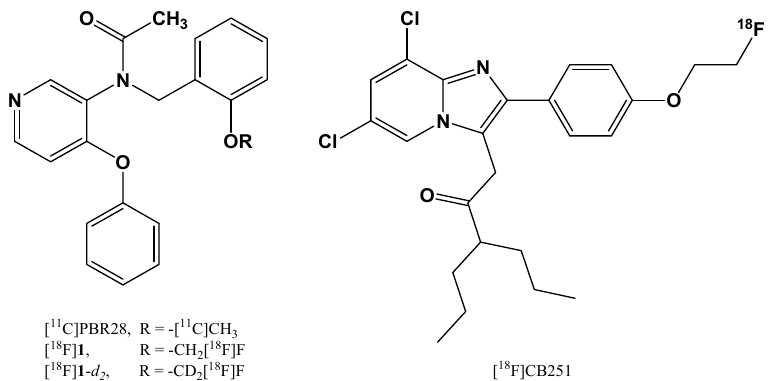
Figure 1. Chemical structures of [ 11 C]PBR28, [ 18 F]fluoromethyl-PBR28 [ 18 F]1, its deuterate aryloxyanilide analog [ 18 F]1-d 2 , and [ 18 F]CB251.